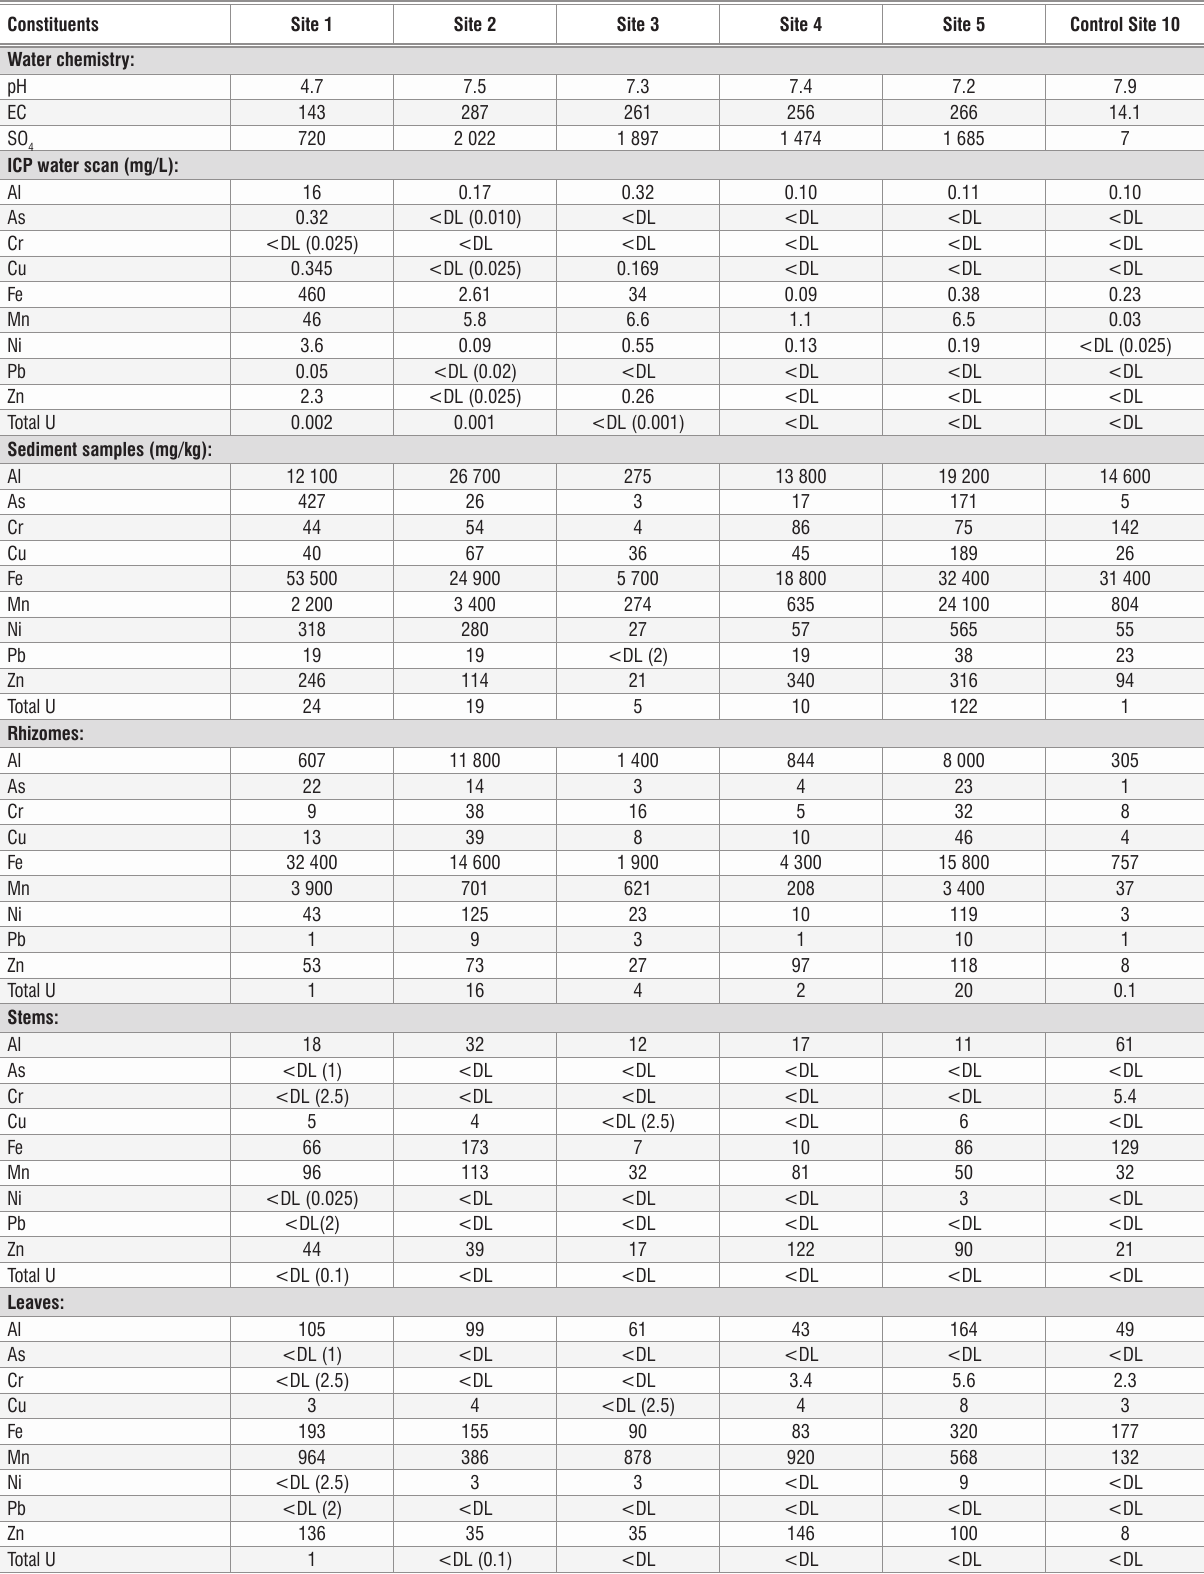
Table 3: Water chemistry and metal concentrations in sediments and rhizomes, stems and leaves of Phragmites australis , sampled in the winter of 2009 along five sites downstream of the decant site in the Tweelopiespruit. Control Site 10 was located in the Walter Sisulu Botanical Gardens. Elevated concentrations of sulphates, Al, Cu, Mn, Ni and total U are seen when comparing the Tweelopiespruit to the control site. Fe is high at both sites, testifying to the naturally high Fe content of the geology. Control Site 10 has high Al, which can be attributed to a sewer pipe leak in the stream draining through the Botanical